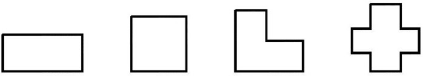
Table 1. Criteria ( c